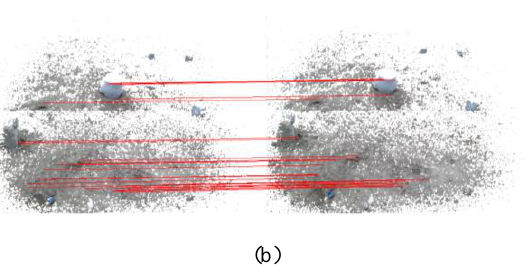
Figure 5. Features detection and matching results. (a) initial matching results (b) matched points after RANSAC